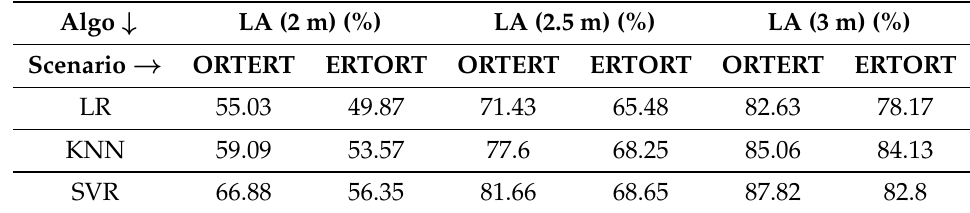
Table 10. LA analysis with different d max values for two scenarios.